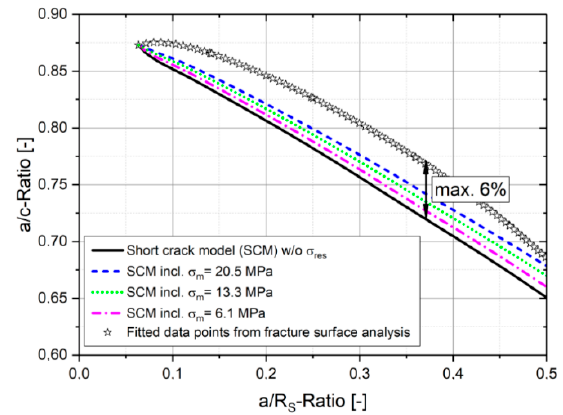
Figure 12. Crack shape evolution compared to fracture surface analysis.